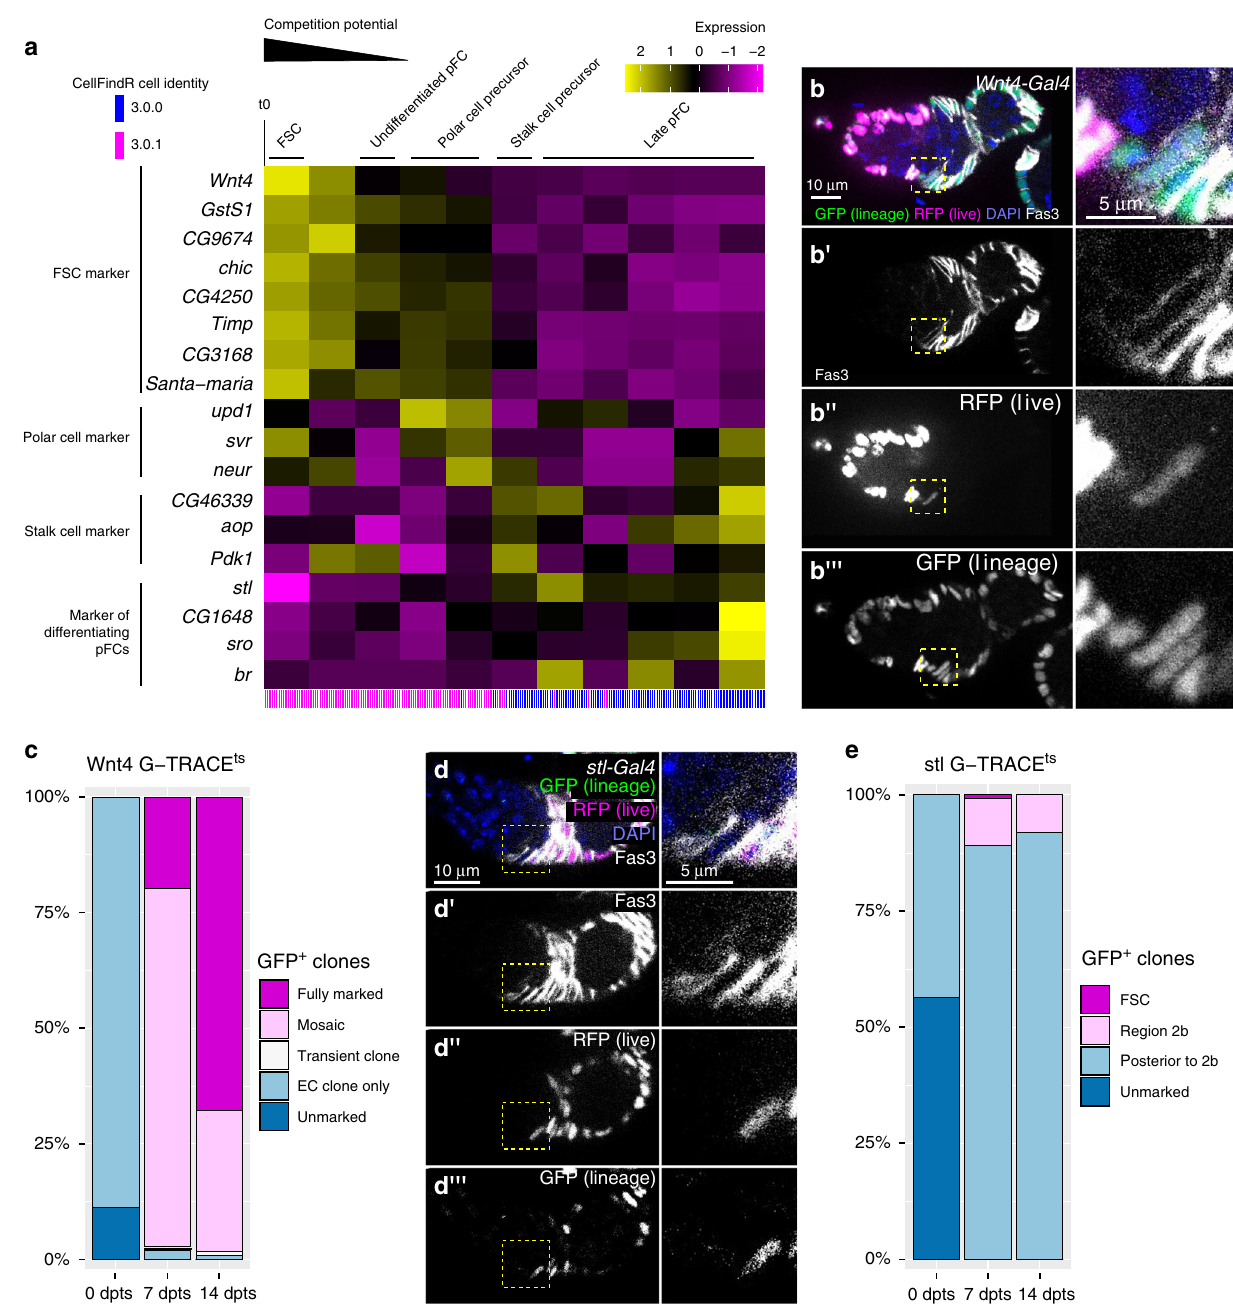
Fig. 5 The early FSC lineage. a Heat map showing gene expression across pseudotime in the FSC and pFCs clusters. Blue and magenta lines indicate the original CellFindR identity. b Germarium with Wnt4-Gal4 driving G-TRACE ts stained for RFP (magenta), GFP (green), Fas3 (white), and DAPI (blue). Inset shows Wnt4-Gal4 low Fas3 + cell at the Fas3 boundary. Fas3 ( b ’ ), RFP ( b ” ) and GFP ( b ”’ ) are also shown in white. c Quanti fi cation of ovarioles with Wnt4- Gal4 driving G-TRACE ts without GFP-positive cells (unmarked), with only EC clones, transient follicle cell clones, mosaic labeling of the follicle epithelium or a fully marked follicle epithelium at 0, 7, or 14 days post temperature shift (dpts). The presence of ovarioles with EC clones at the 0 dpts time point is likely because this is where Wnt4-Gal4 activity is strongest and Gal4 may not be fully repressed by Gal80 in these cells. Notably, we never observed GFP + follicle cell clones at 0 dpts, consistent with lower expression of Wnt4-Gal4 in FSCs. n = 149, 156 and 120 ovarioles for 0, 7 or 14 dpts respectively. d Germarium with stl-Gal4 driving G-TRACE ts stained for RFP (magenta), GFP (green), Fas3 (white), and DAPI (blue). stl-Gal4 drives RFP expression sparsely in pFCs in the 2b Region and is consistently expressed in Region 3. GFP + clones typically include pFCs in region 2b (inset) but not FSCs or pFCs at the 2a/2b border. Fas3 ( d ’ ), RFP ( d ” ) and GFP ( d ”’ ) are shown separately in white. e Quanti fi cation of ovarioles with stl-Gal4 driving G-TRACE ts without GFP-positive cells (unmarked), with FSC clones, transient follicle cell clones located in Region 2b, or transient follicle cell clones posterior to Region 2b at 0, 7 or 14 dpts. Ovarioles at the 0 dpts frequently contained small GFP + clones of up to 4 cells posterior to region 3. These clones were usually con fi ned to stalk cells where stl-Gal4 activity is strongest. n = 140, 135 and 128 ovarioles for 0, 7 or 14 dpts respectively. FSC: follicle stem cell; pFC: prefollicle cell; EC: escort cell; dpts: days post temperature